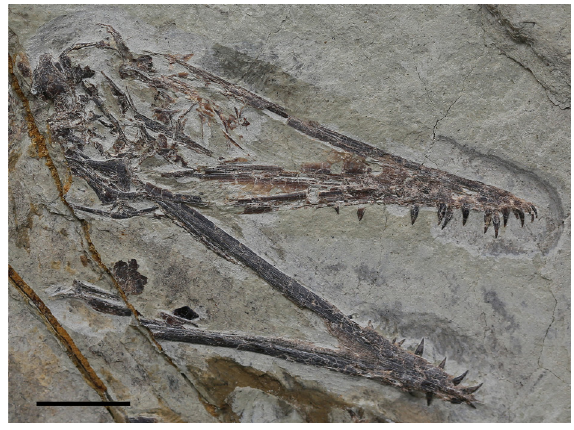
Figure 2. Photo of the upper and lower jaws of the juvenile individual (STM 19-59) of Kunpengopterus sinensis . Scale bar, 10